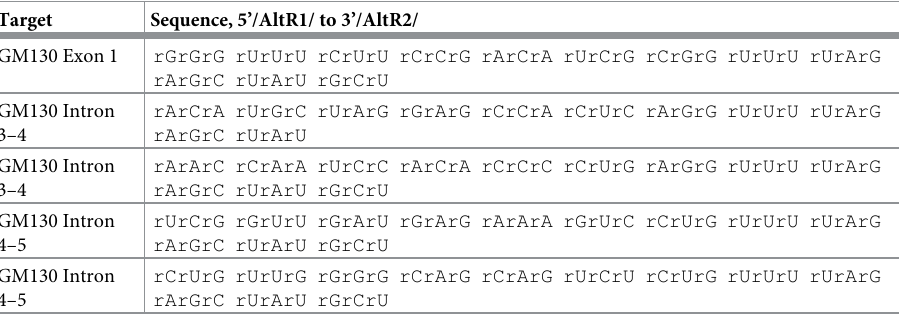
Table 1. GM130 specific gRNA